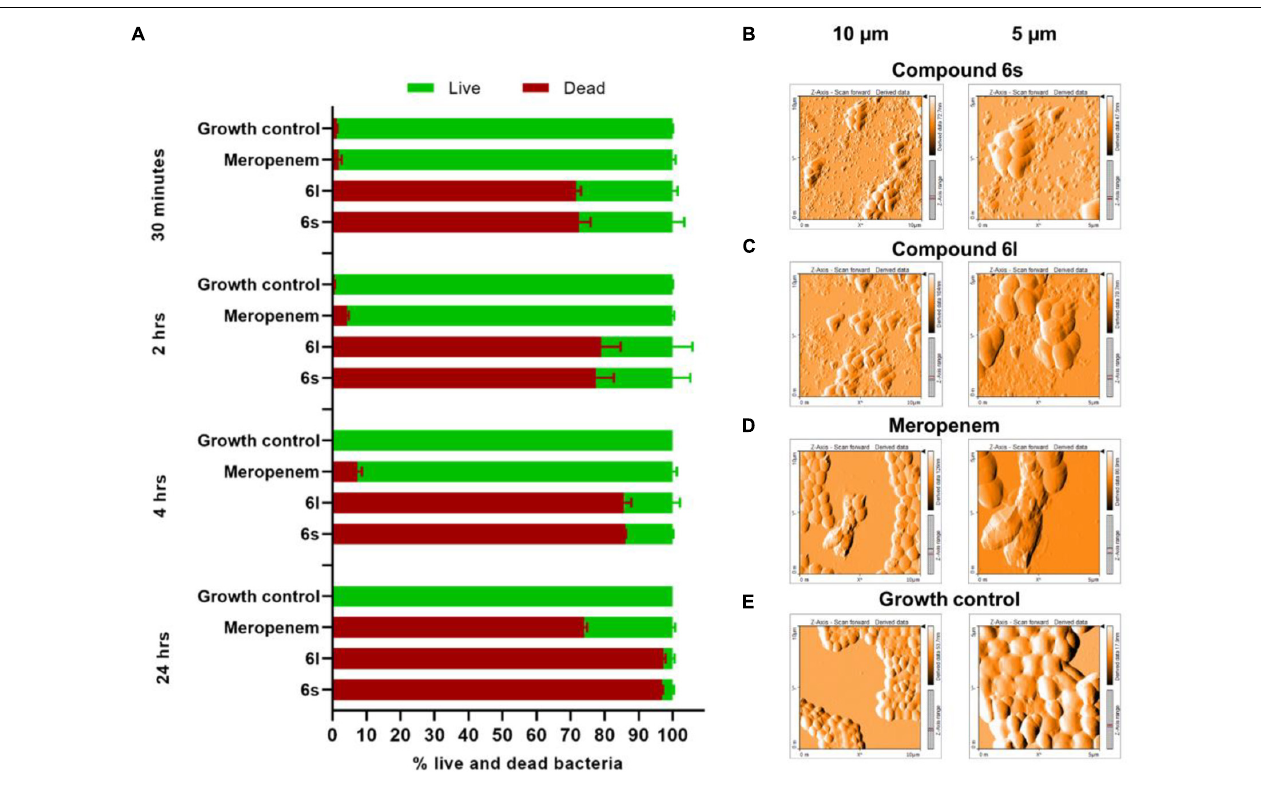
FIGURE 3 | Microscopic examination of bacteria treated with test compounds: (A) Fluorescence microscope after staining with SYTO-9 (membrane permeable/green) and propidium iodide (membrane impermeable/red). MRSA-1 cultures ( ∼ 2 × 10 5 CFU/ml) were treated with compounds 6s , 6l or control antibiotic meropenem for the indicated time. Results are the average of three independent experiments. Cells which stained green were counted as live whereases cell that stained red or yellow were counted as dead. (B–E) Atomic force microscopy of MRSA-1 ( ∼ 10 8 CFU/ml) treated with compounds 6s (B) and 6l (C) or control antibiotic meropenem (D) at a concentration of 50 µ g/ml for 4 h. Growth control (E) indicates untreated MRSA-1